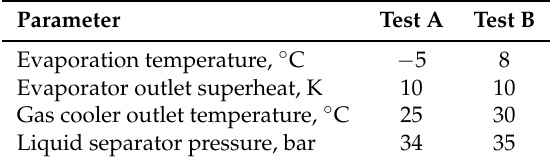
Table 4. Operating conditions of the R744 vapour compression system adapted from